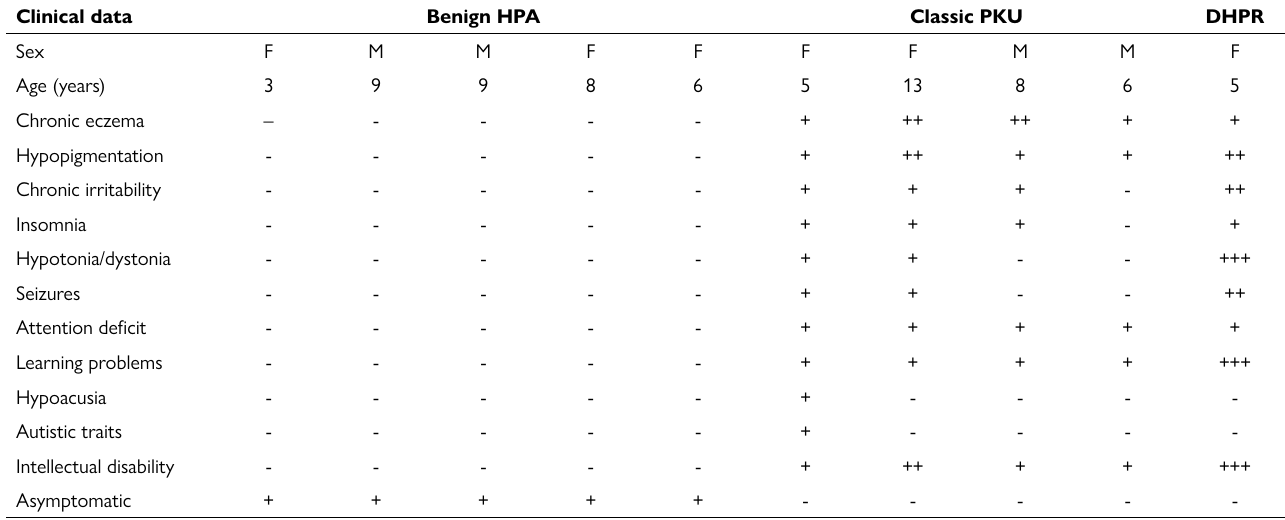
Table 2. Clinical findings at initial consultation of older siblings diagnosed after the newborns with HPA detected by NBS. (The presence or absence of symptoms is represented with + or -, respectively;